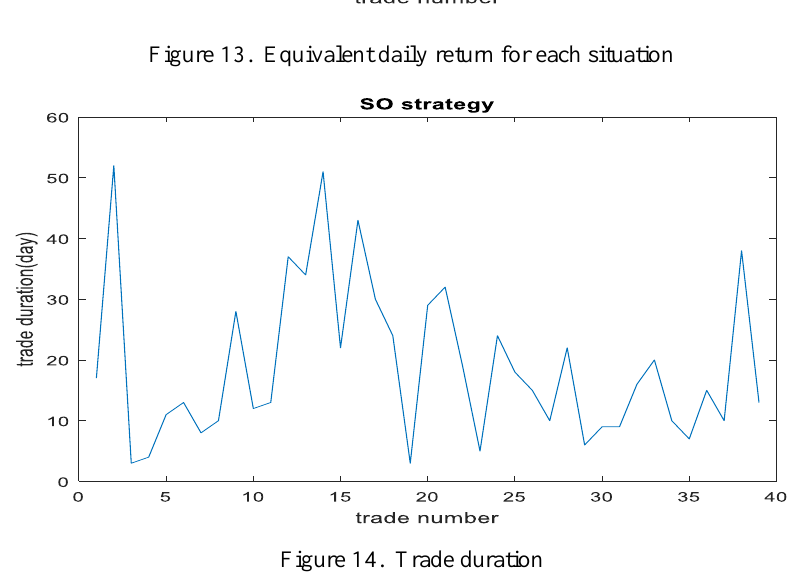
Figure 14. Trade duration